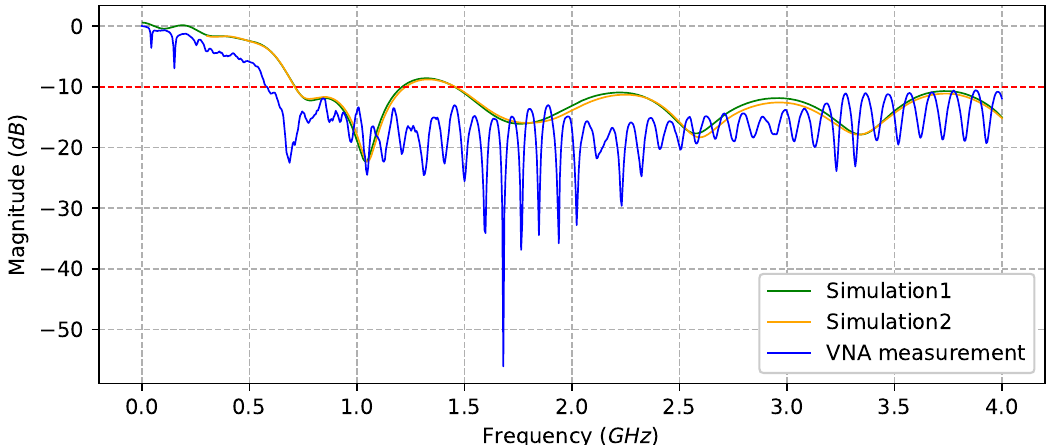
Figure 5. S 11 scatering parameters of simulated VH antenna without form holder (solid orange line), with form holder (solid green line), and measured VH antenna (solid blue line). The dashed red line indicates the limiting magnitude from where the antenna is suitable for the selected